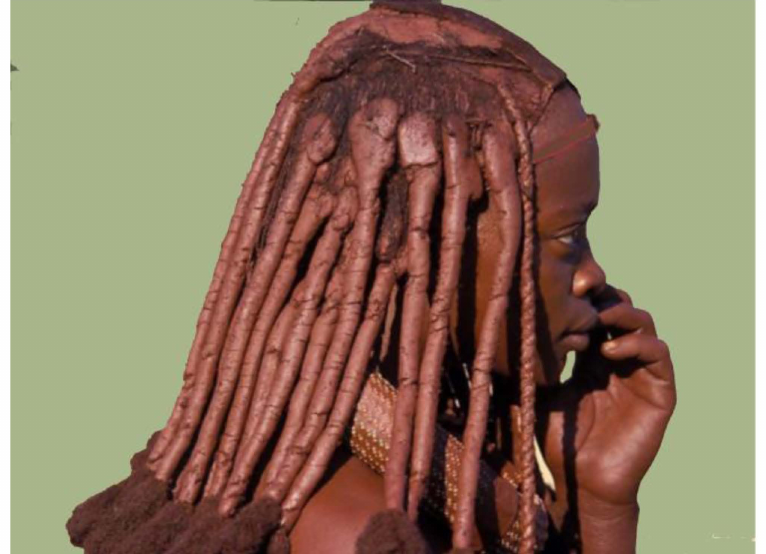
Figure 5. Himba women use ochre mixed with fat and herbs to treat daily the skin and the hair. They consider this as a cosmetic as well as health-supporting procedure (Helmut